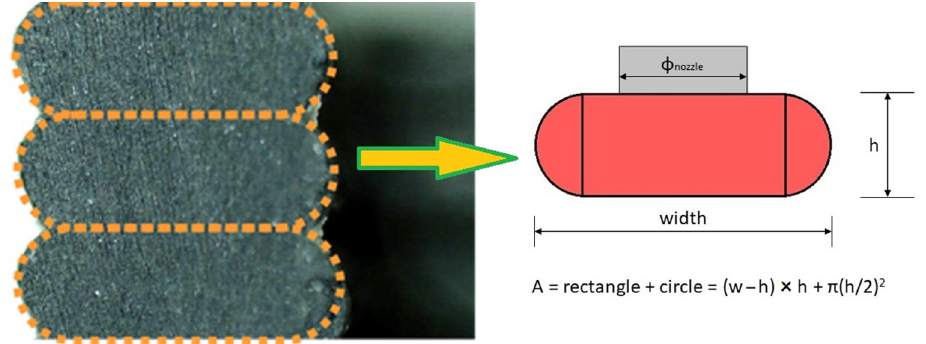
Figure 3. Printing line geometry characterization.